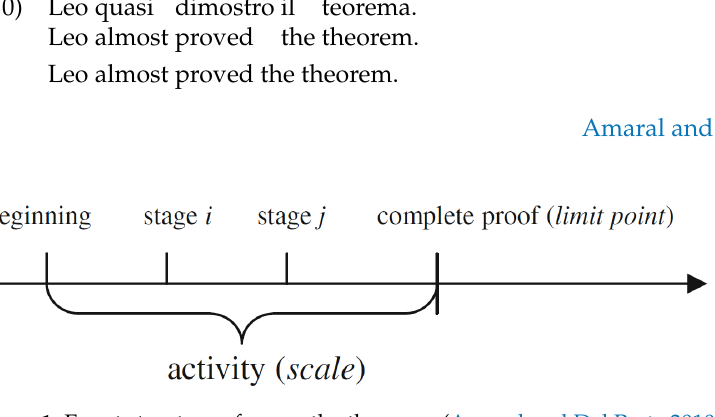
Figure 1. Event structure of prove the theorem. (Amaral and Del Prete 2010; Figure